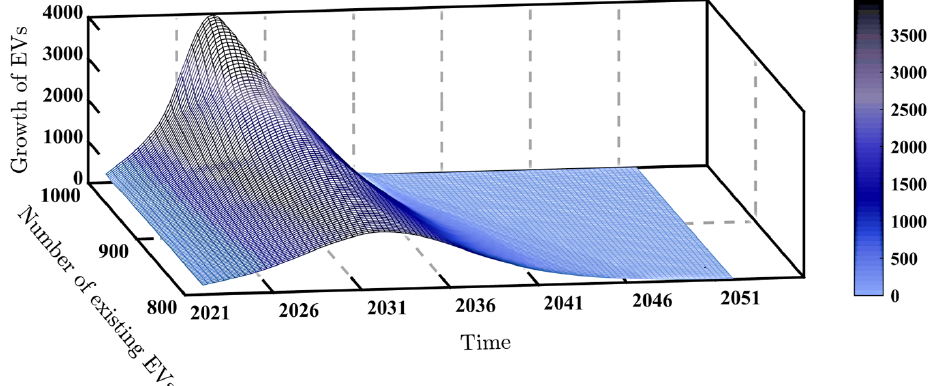
Figure 7. Growth of EVs changes with the number of existing